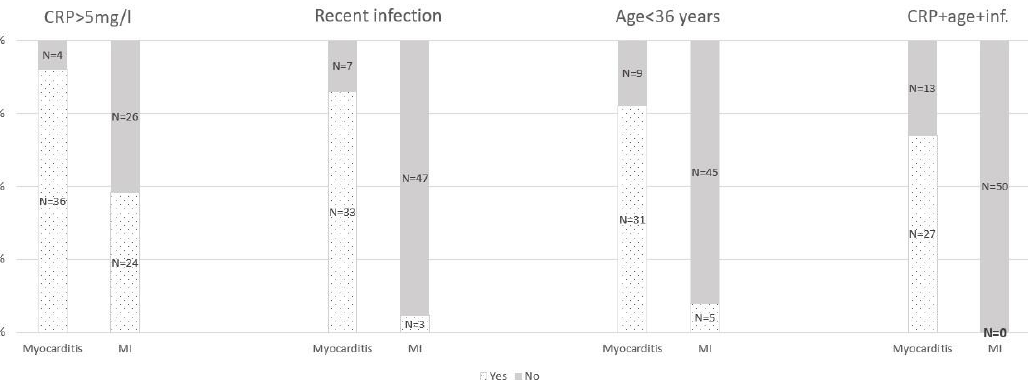
Figure 4. Three-dimensional charts showing the distribution of variables based on age, CRP level